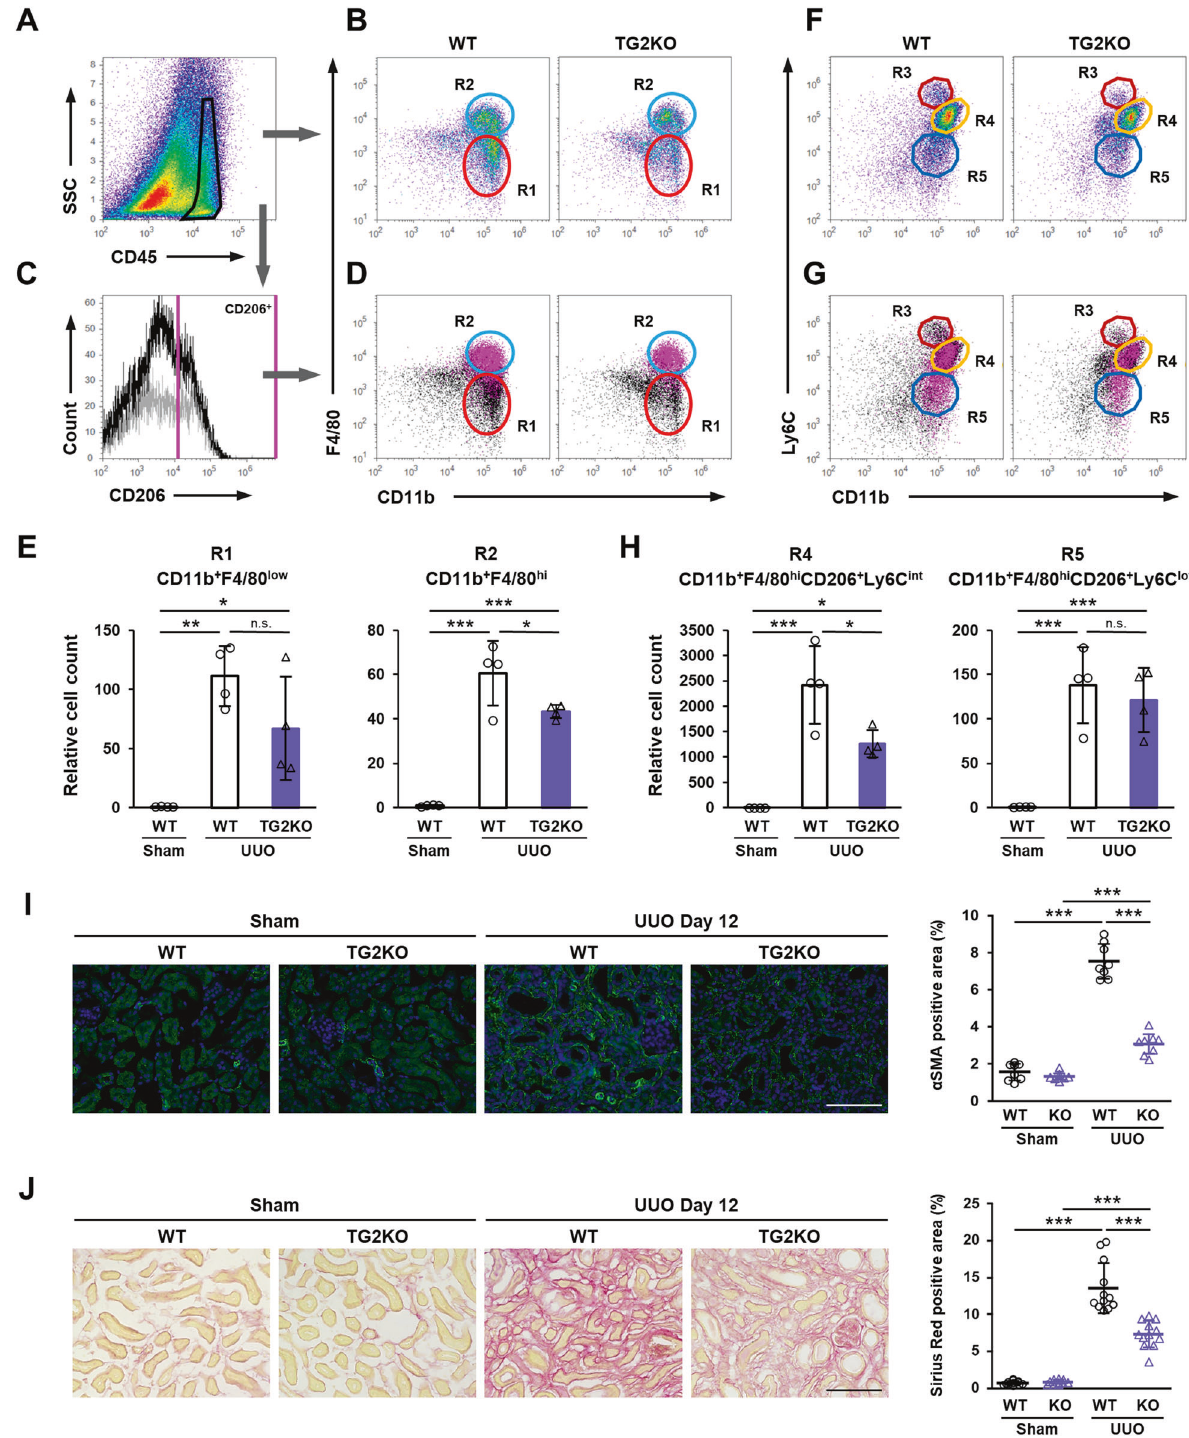
Fig. 2 Characterization of in fi ltrated macrophage into fi brotic kidney after UUO surgery. CD45-positive cells from fi brotic kidney in WT and TG2KO mice were divided ( A ) into the CD11b + F4/80 low (R1) and CD11b + F4/80 hi (R2) groups ( B ). SSC side scatter. CD206-positive cells from WT (black) and TG2KO (gray) mice were selected in histogram plot ( C ) and colored with magenta in the dot plots shown in B ( D ). The relative cell counts of two groups were indicated ( E ). CD45-positive cells were also divided into the CD11b + Ly6C hi (R3), CD11b + Ly6C int (R4), and CD11b + Ly6C low (R5) groups ( F ). CD206-positive cells were colored with magenta in the dot plots shown in F ( G ). The relative cell counts of R4 and R5 groups gated by both F4/80 hi and CD206 + were indicated ( H ). Myo fi broblasts in kidney sections were stained using anti- α -SMA antibody plus AlexaFluor 488 goat anti-rabbit IgG and the percentages of their positive area are presented ( I ). The nuclei were counterstained with DAPI. The collagen fi bers in kidney sections were detected by picrosirius red staining and the percentages of their positive area are presented ( J ). Scale bars = 100 μ m. Representative results in at least three independent samples were shown. (* P < 0.05, ** P < 0.01, *** P < 0.001 by one-way ANOVA with post hoc Tukey ’ s multiple comparisons test).